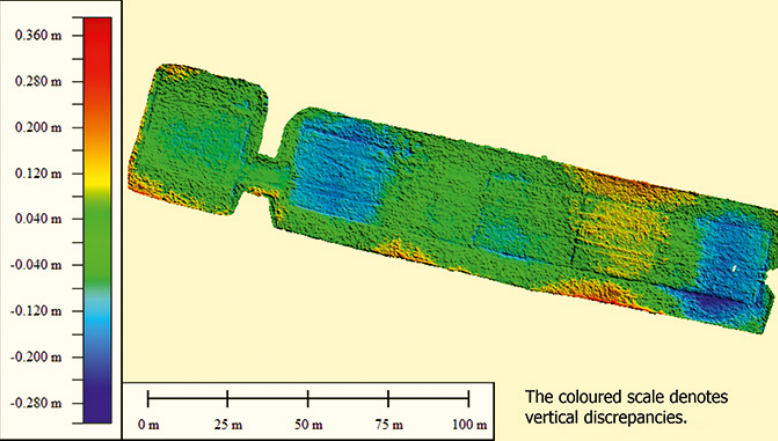
Note: flight height of both at 60